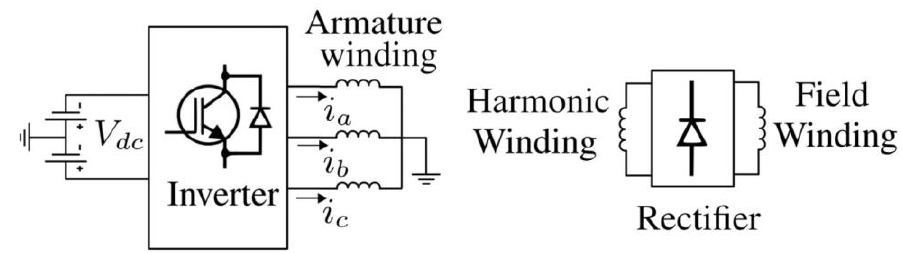
Figure 2. Simplified diagram of the proposed brushless WFSM drive topology.